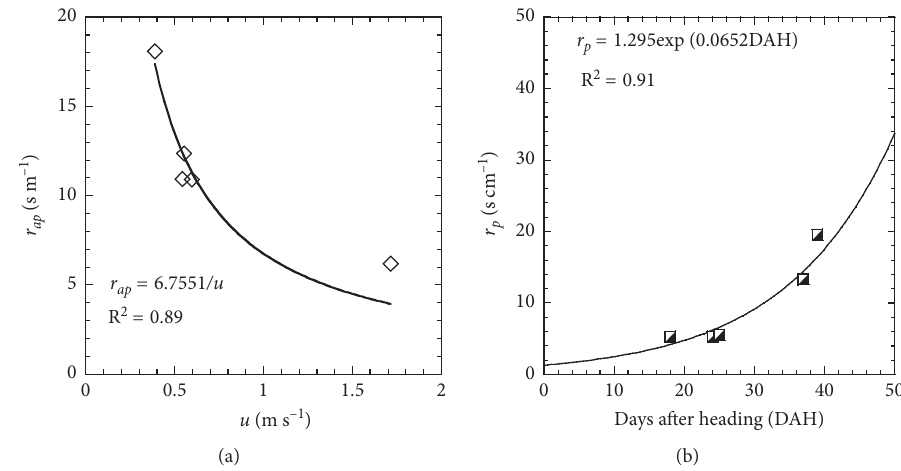
Figure 5: Relationship between wind speed ( u ) and aerodynamic resistance to the transfer of sensible heat between panicle and atmosphere ( r ap ) in the rice paddy field on August 5, 7, 18, 26, and 28, 2014 (a). Change of panicle transpiration resistance ( r p ) against the days after heading (DAH) in the rice paddy field on August 12, 18, 19, and 31 and September 2, 2014